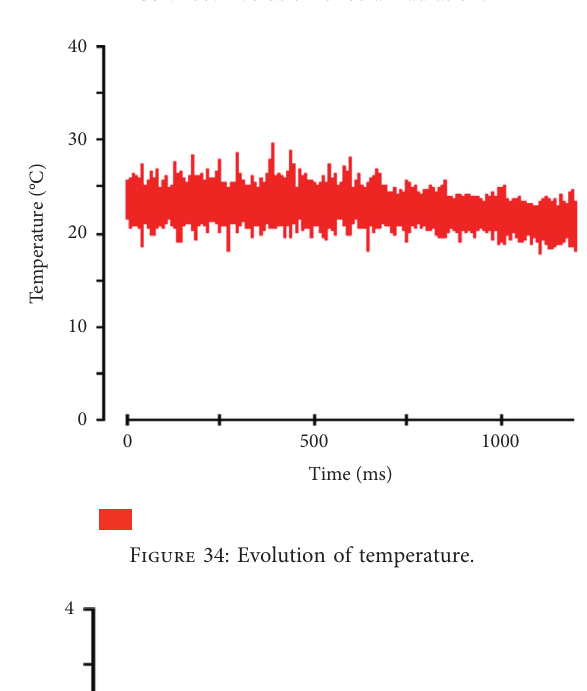
Figure 33: Evolution of solar radiation.